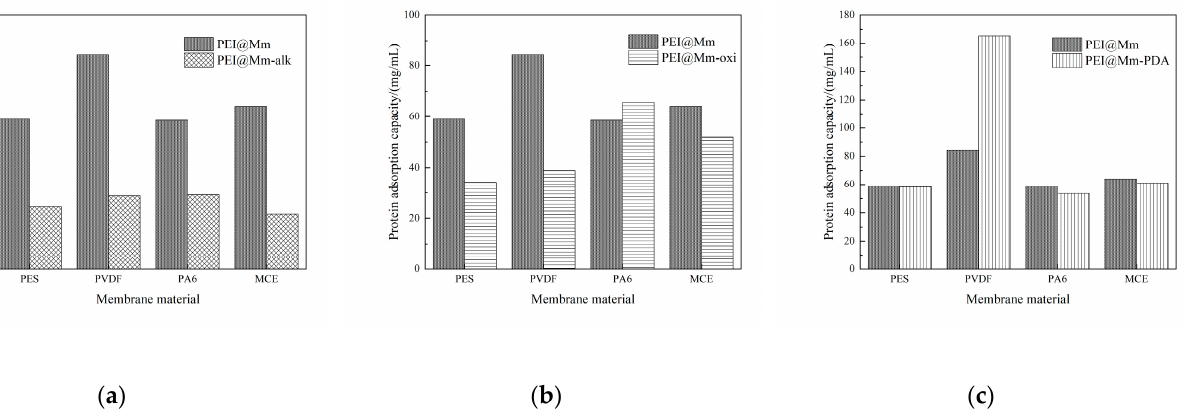
Figure 5. Effect of ( a ) alkali treatment, ( b ) oxidation treatment and ( c ) PDA deposition on the protein adsorption performance of the MAs.